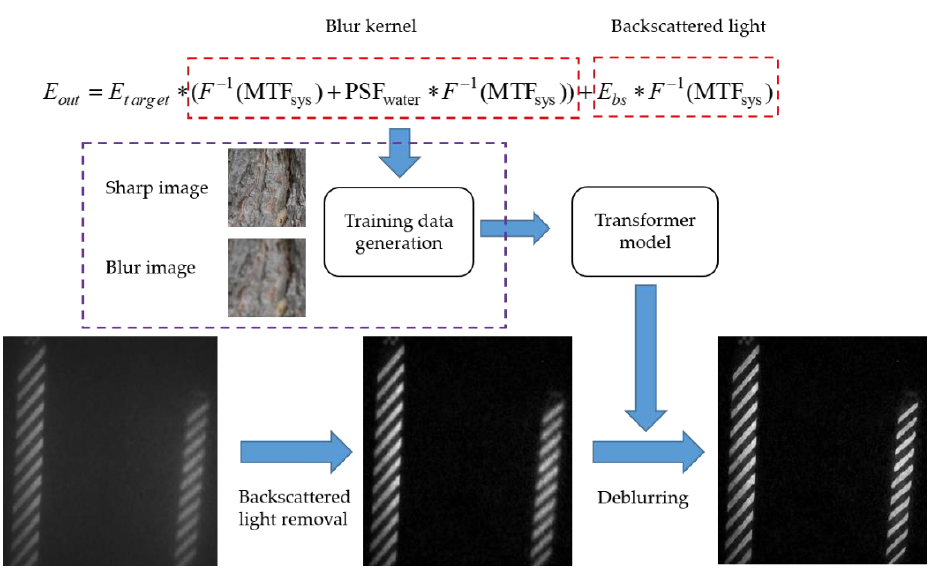
Figure 3. Flowchart of the proposed method.